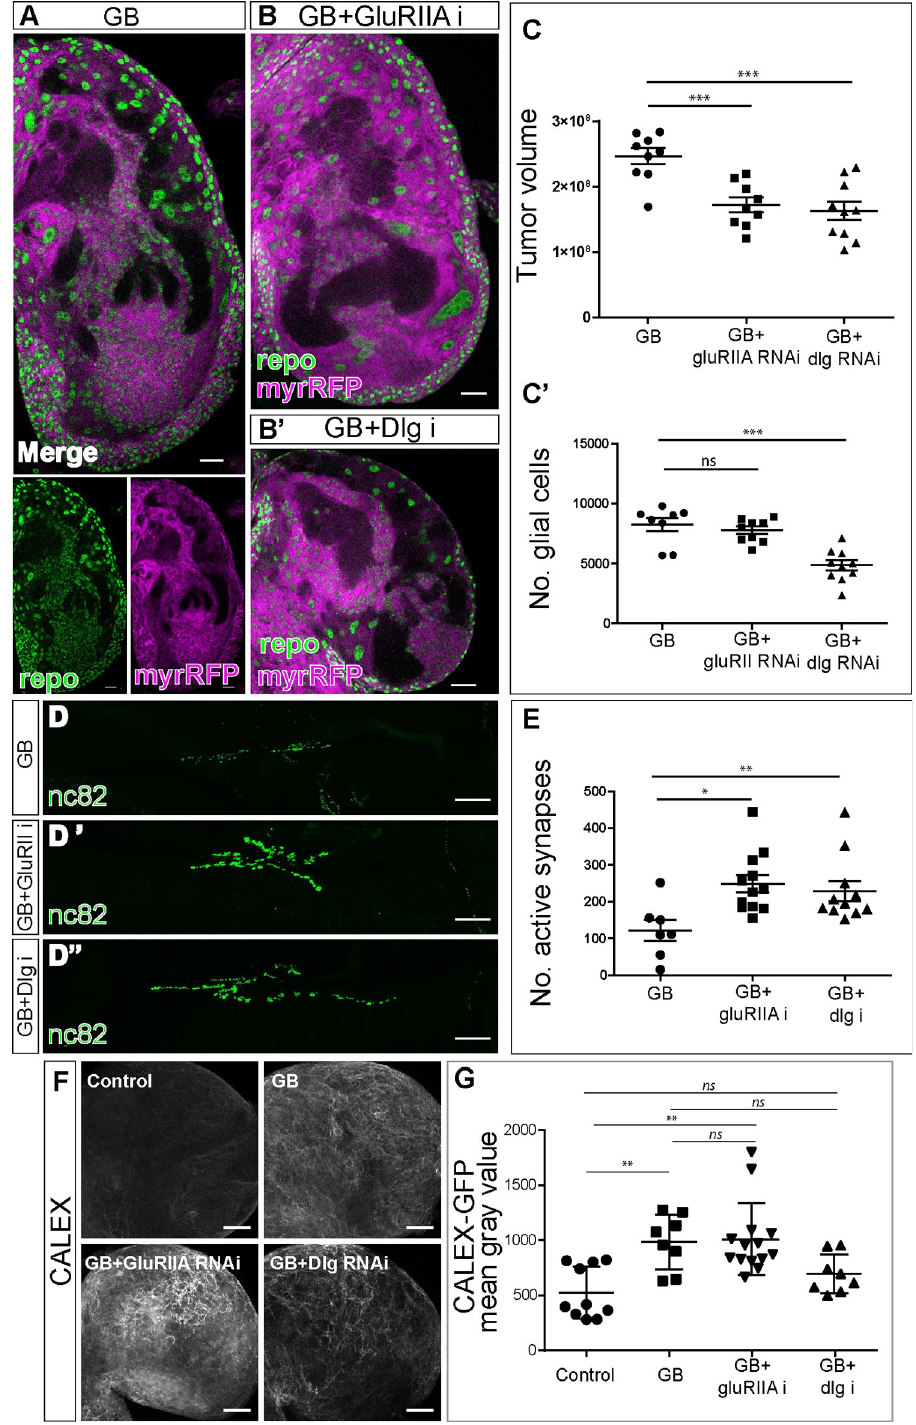
Fig 2. Postsynaptic proteins GluRII and Dlg are required for GB progression. A) Representative confocal image of GB larval brain lobe showing glial nuclei (green) and glial membrane (magenta). Bottom images show green and magenta channels separately. B-B’) Representative confocal images of GB larval brain lobe + GluRIIA RNAi expression (B) or dlg RNAi expression (B’) in GB cells. Glial nuclei are shown in green and glial membranes in magenta. C) Quantification of GB membrane volume (C, No. � 8 brain lobes) or number of glial cells (C’, No. � 8 brain lobes) in GB and GB with GluRIIA or dlg RNAi. Statistics: Dunnett’s Multiple Comparison Test ( ��� p < 0.0001). D) Confocal